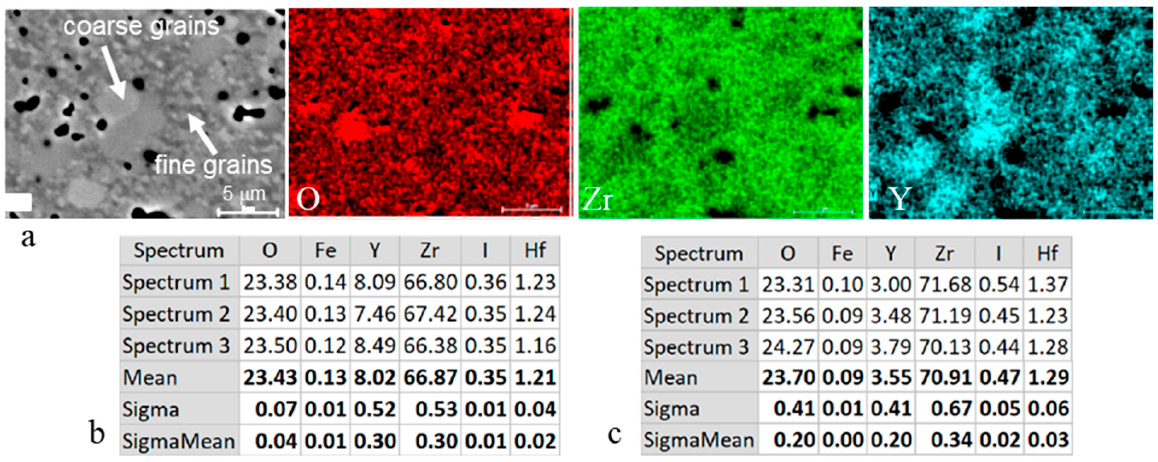
Figure 5. Chemical analysis of the 6YSZ ceramic sintered at 1500 °C: ( a ) SEM-BSE image and EDS maps of O, Y, and Zr with chemical compositions measured for ( b ) coarse and ( c ) fine grains.